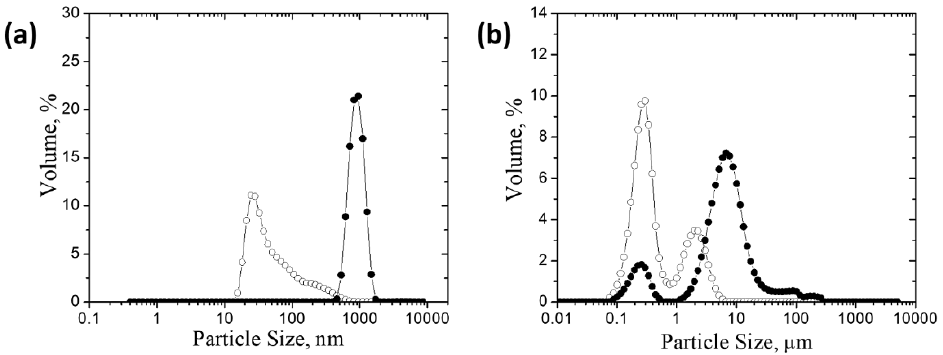
Figure 8. Particle size distribution for NP particles ( a ) and BM particles ( b ); initial pesticide parti- cles (empty symbols); aggregates obtained in the presence of P- g -pAPTAC3 , dose op = 18 mg ∙ L − 1 , (c%, v/v = 0.7) and in the presence of P- g -pAPTAC2 , dose op =10 mg ∙ L − 1 , (c%, w/w = 0.05) (solid